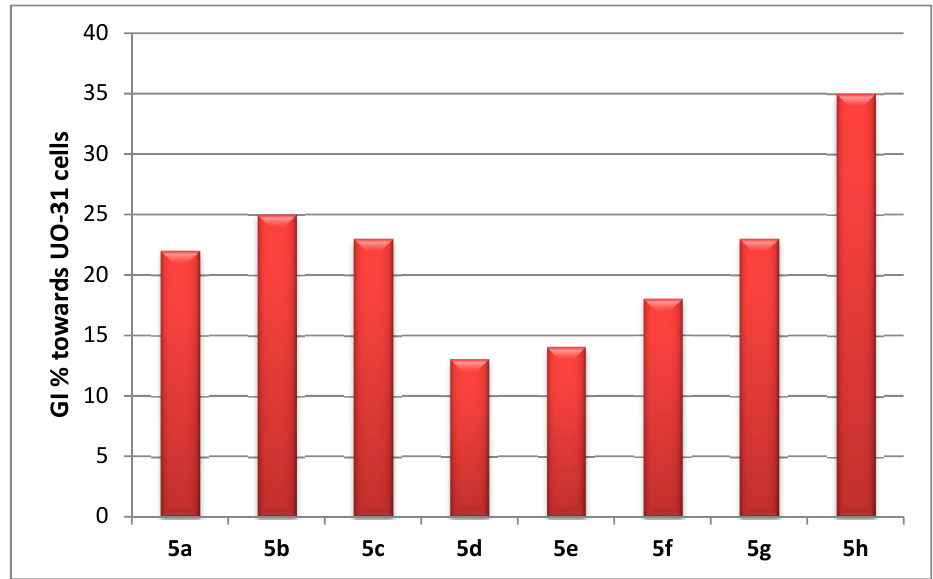
Figure 2. Percentage growth inhibition (GI%) for the target diamide-based benzenesulfonamides 5a – h towards the renal cancer UO-31 cell line.